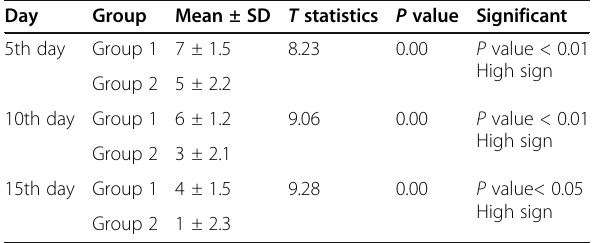
Table 3 Pain intensity score postoperatively Day